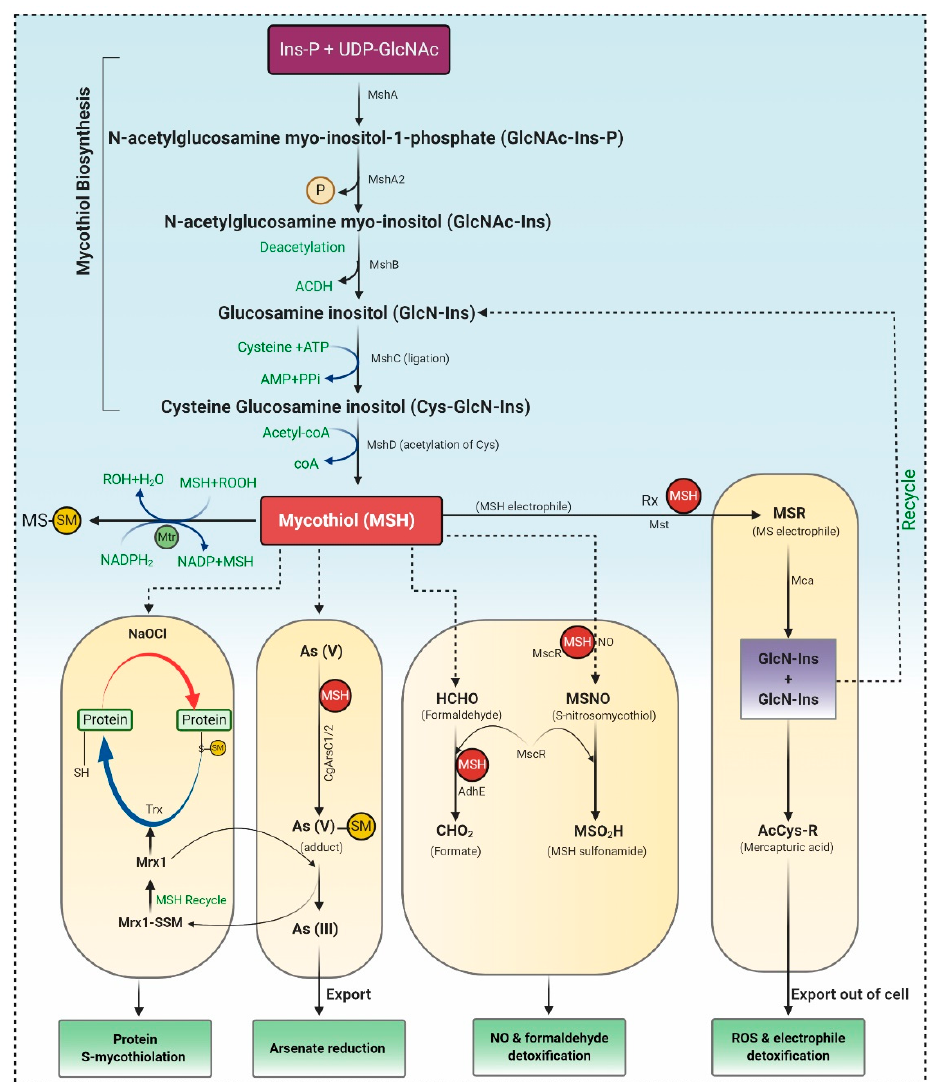
Figure 2. MSH biosynthesis and regulation in actinomycetes. Synthesis of MSH is catalyzed